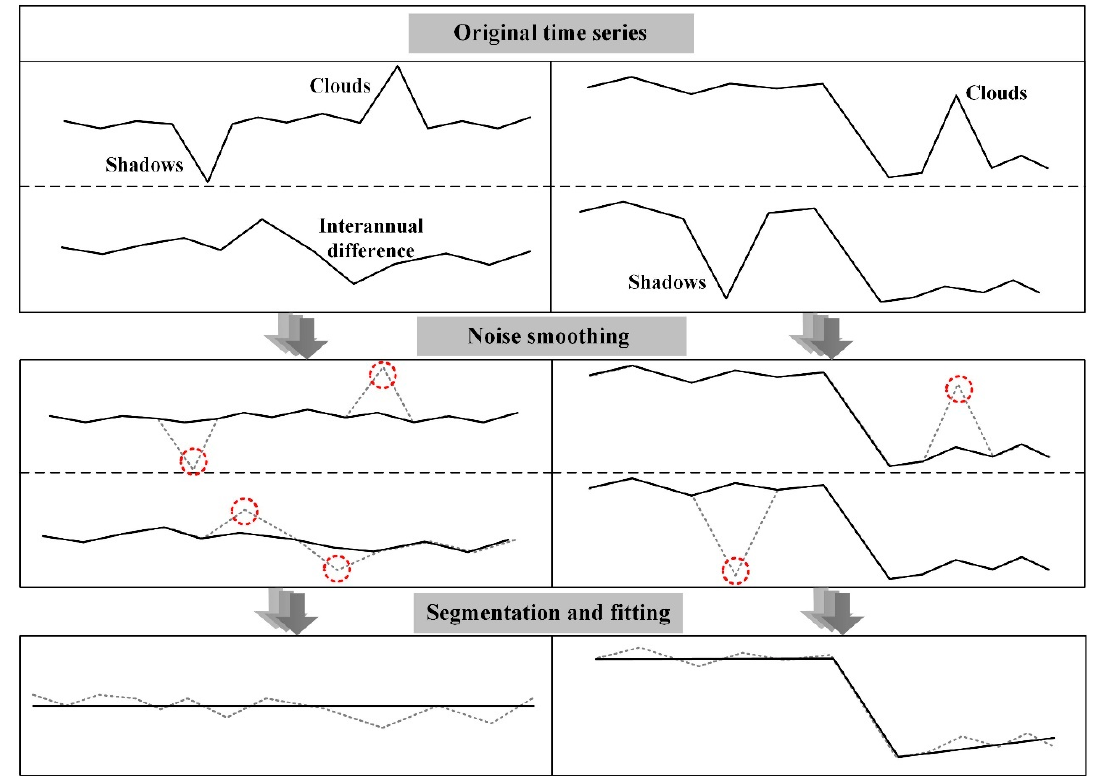
Figure 3. The procedures for noise smoothing and segmentation in LandTrendr.